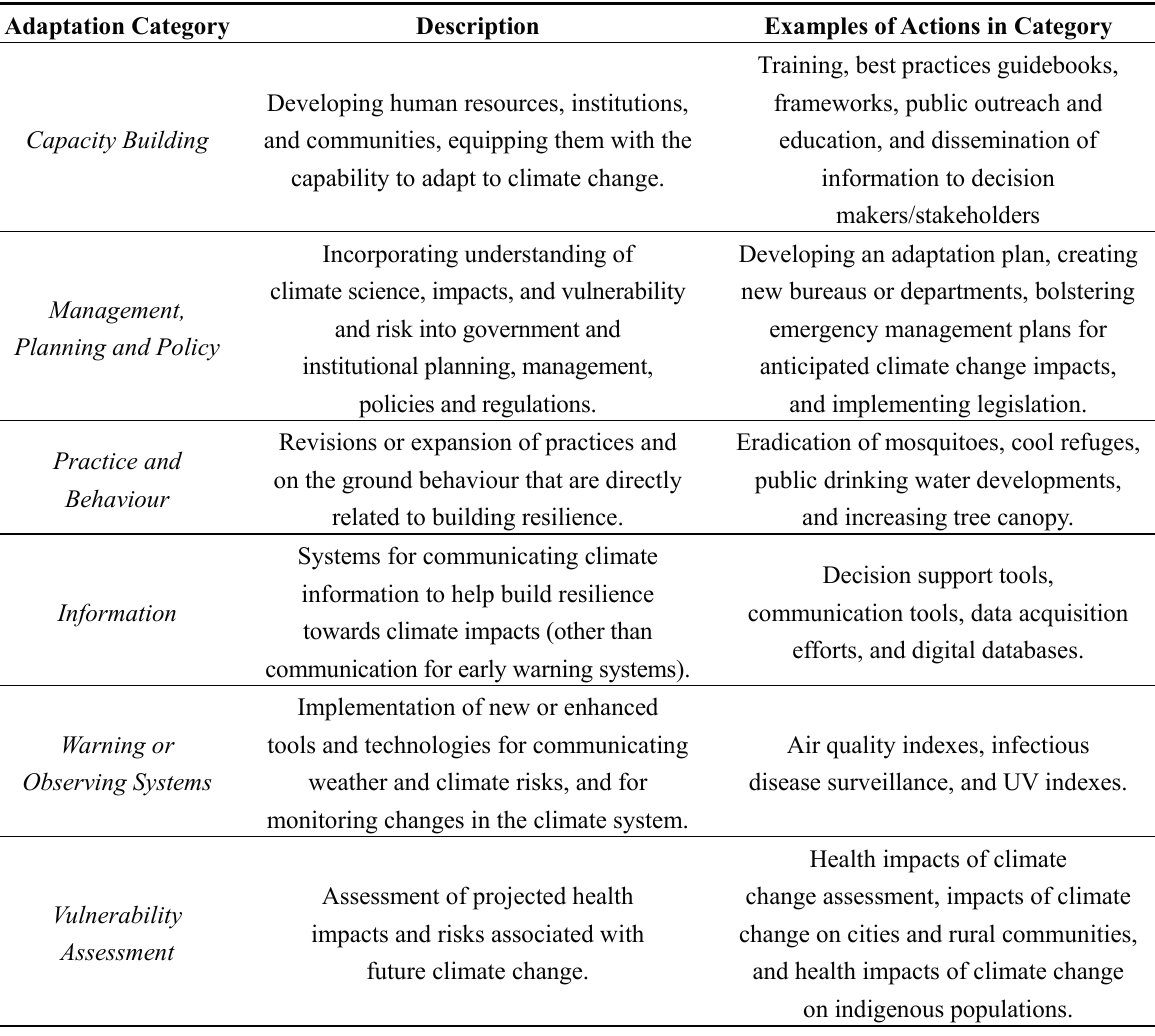
Table 1. Health adaptation initiatives included, by adaptation